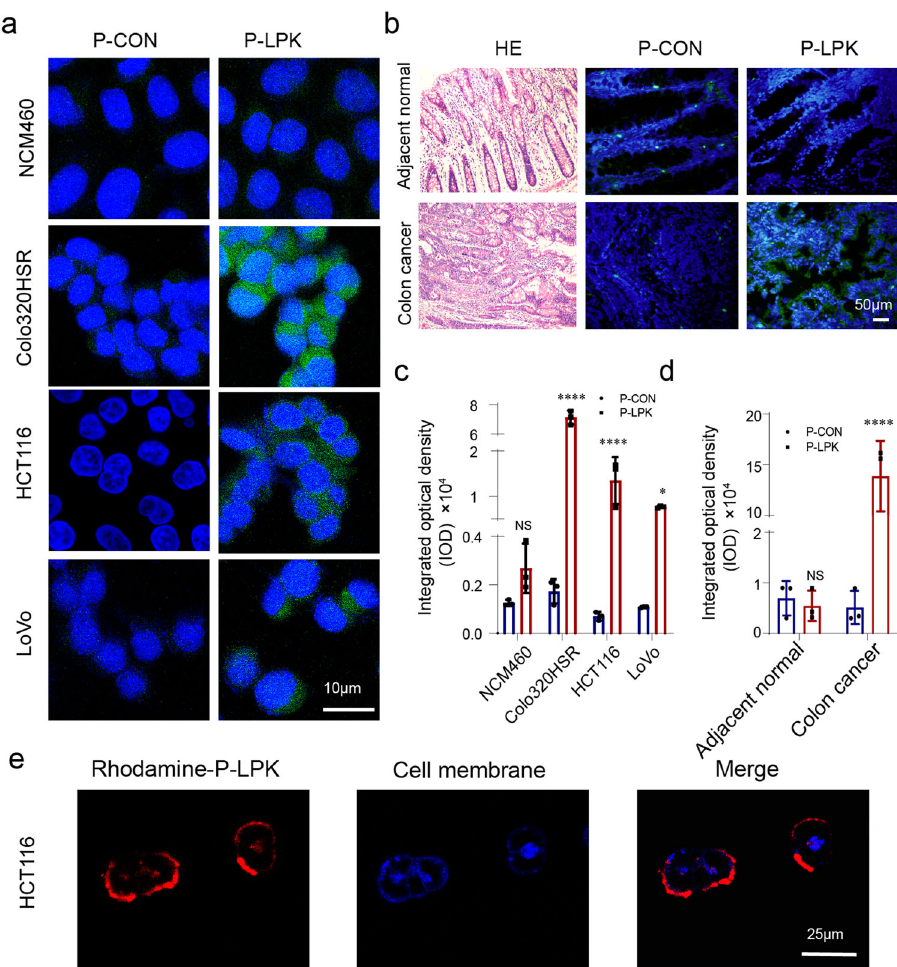
Fig. 1 Fluorescent images of P-LPK binding to human CRC cells and cancer tissues. a The FITC-P-LPK conjugate emitted stronger green fl uorescence in CRC cells than normal NCM460 cells. Bar,10 μ m. b The FITC-P-LPK conjugate selectively binds to CRC tissues (HE staining) Bar, 50 μ m. c , d The fl uorescence intensity of the P-LPK peptide in CRC cells ( c ) and tissues ( d ) was signi fi cantly higher than that of normal cells and tissues ( n = 3, means ± SD, NCM460: P-CON vs P-LPK, p = 0.9385; Colo320HSR: P-CON vs P-LPK, p < 0.0001; HCT116: P-CON vs P-LPK, p < 0.0001; LoVo: P-CON vs P- LPK, p = 0.0219; Adjacent normal tissues: P-CON vs P-LPK, p = 0.9934;Colon cancer tissues: P-CON vs P-LPK, p < 0.0001) (* p < 0.05, **** p < 0.0001). e The binding site of the P-LPK peptide in HCT116 cells was investigated after labeling the peptide with Rhodamine. Bar, 25 μ